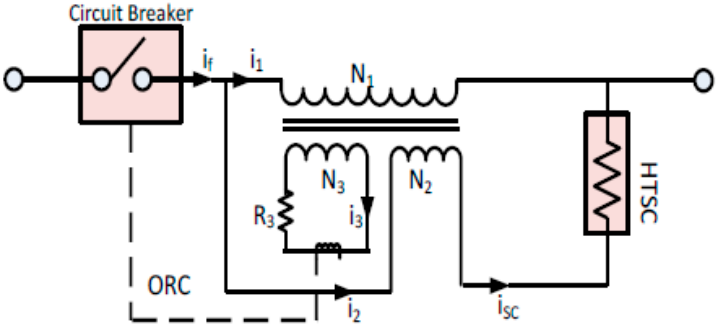
Figure 14. Structure of flux lock type SCFCL.